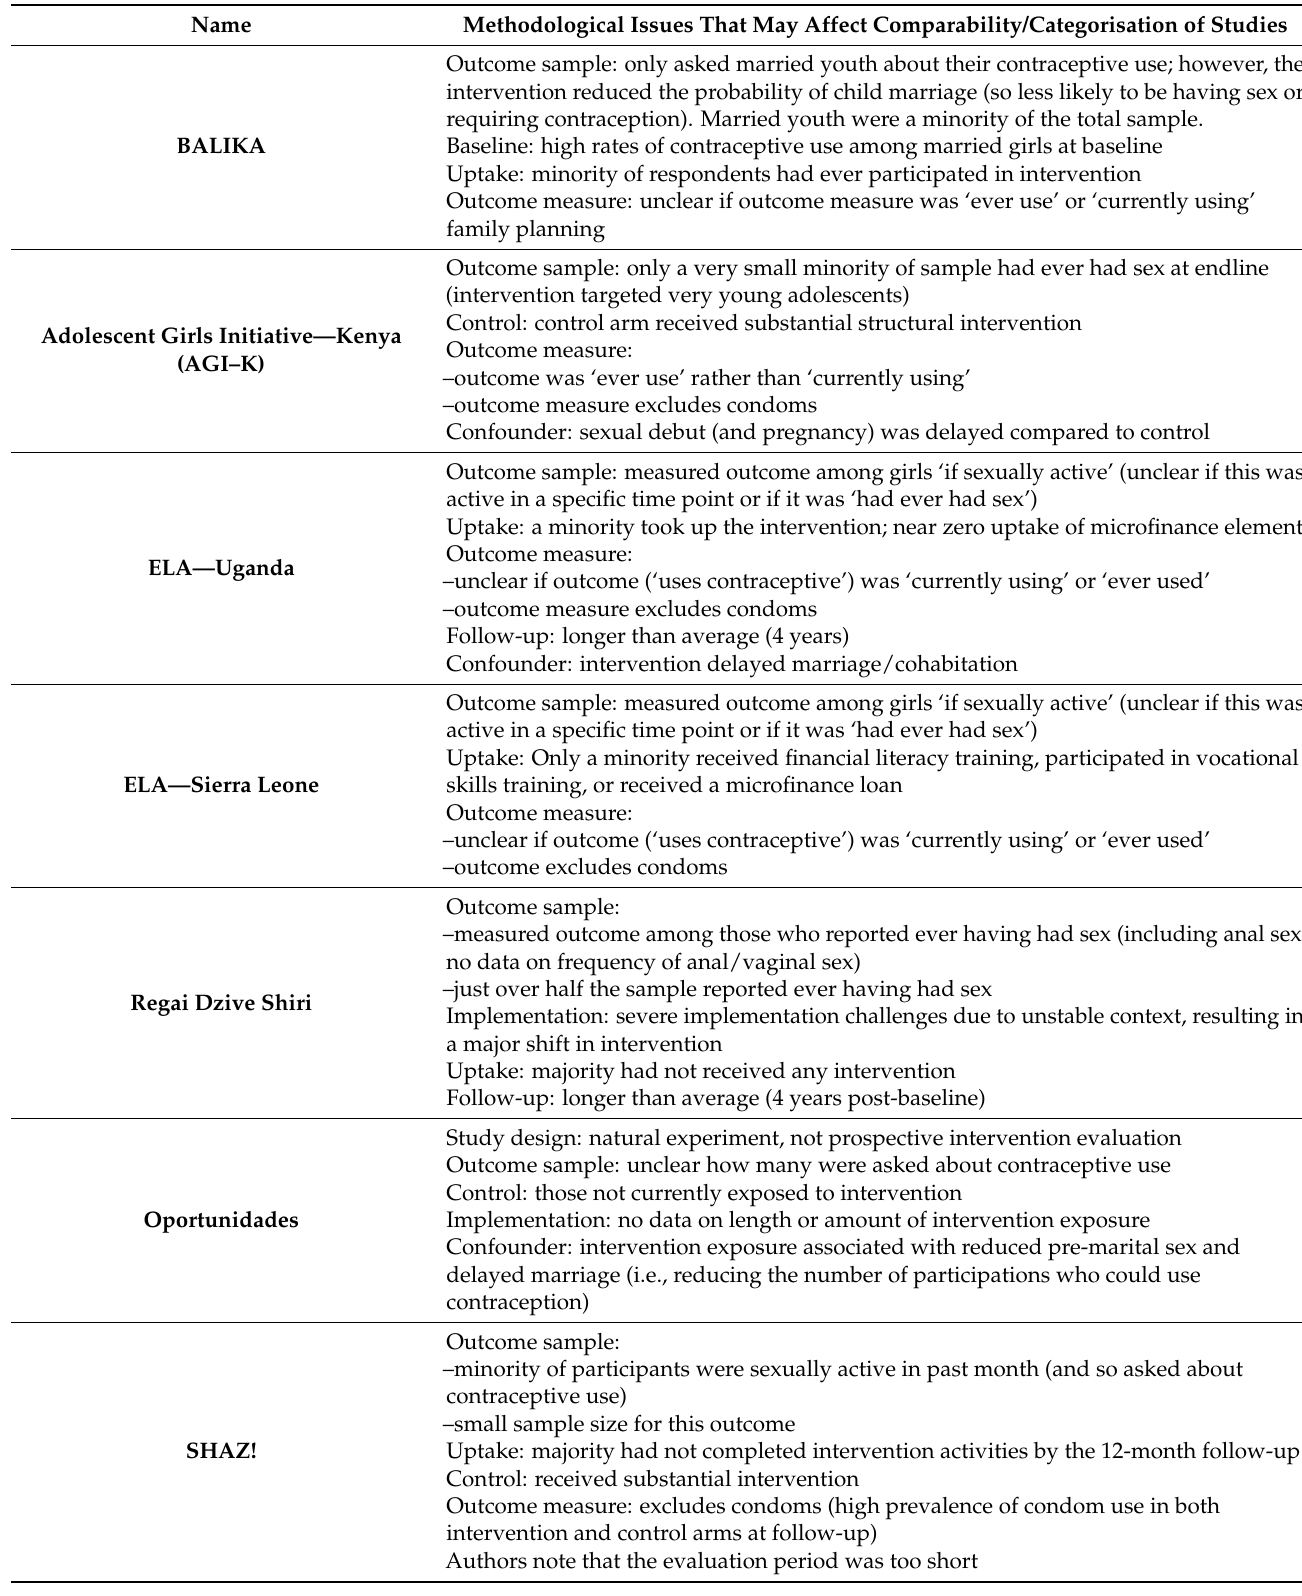
Table A3. Methodological issues of included